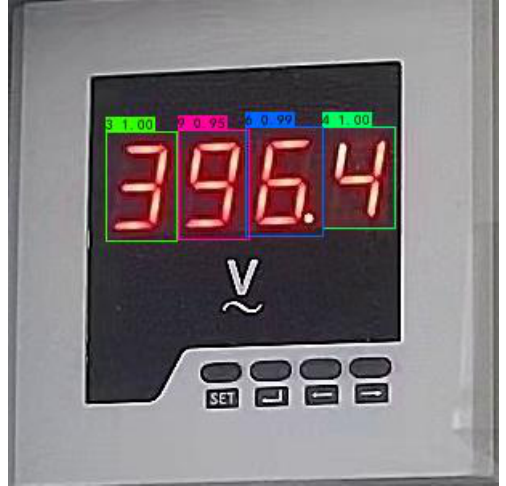
Figure 14. Schematic diagram of successful detection after joining connected domain analysis module. Obtain the area of a single number (possibly with a decimal point), binarize the area, remove noise, morphologically process and find the connected components in the area, and find the area ratio of all two or more connected components, according to whether there is an area ratio, it is judged that the number area contains a decimal point within the set threshold. During the experiment, setting the threshold between 70 and 100 can judge whether the test set contains a decimal point. Figure 15 is part of the actual effect